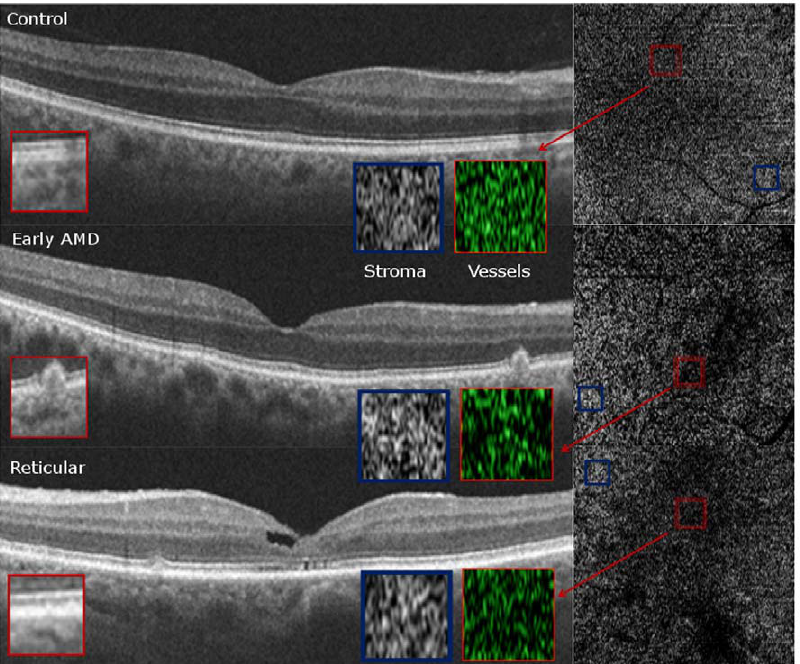
Figure 6. Qualitative Choriocapillaris Assessment Comparing C-Scans and B-Scans (Example 2). Comparing another example of control (top panel), early age-related macular degeneration (AMD, middle panel) and reticular (bottom panel) patients, reveals qualitatively different appearance of representative C-scans obtained just below the retinal pigment epithelium in reticular groups (bottom right) than in the control and AMD groups (top right and center right, respectively). Red boxes on the B-Scans (left) show magnified and colorized selected areas of choroidal vasculature from the regions contained by the smaller red boxes on the C-Scans (right) for each group. Blue boxes on the B-Scans (left) show magnified areas of selected stroma from the regions contained by the smaller blue boxes on the C-Scans (right). Stromal sections demonstrate more patchy whitish regions in the RPD group (bottom panel) as compared to the control and AMD groups (top and middle panels) but similar vessel density due to the presence of larger vessels.